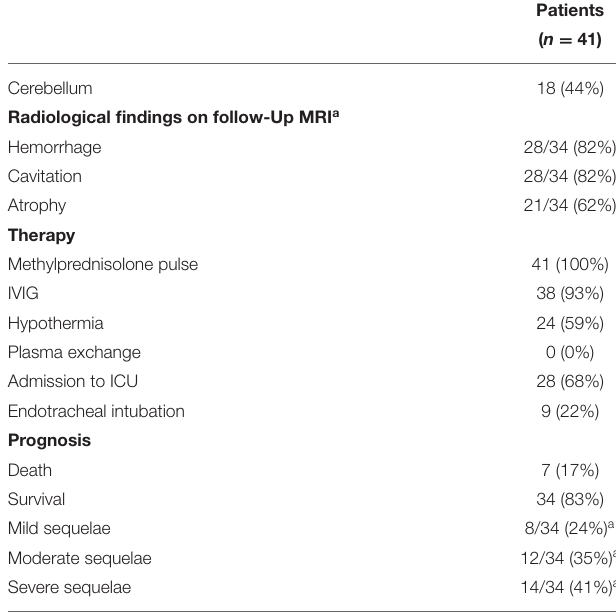
TABLE 1 | Clinical characteristics of 41 pediatric patients with